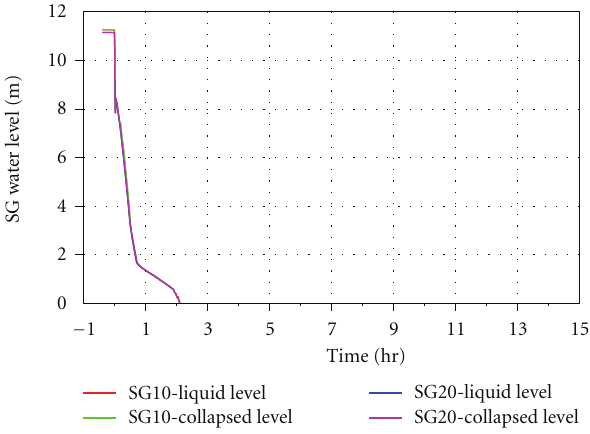
Figure 16: SG10 and SG20 water levels.